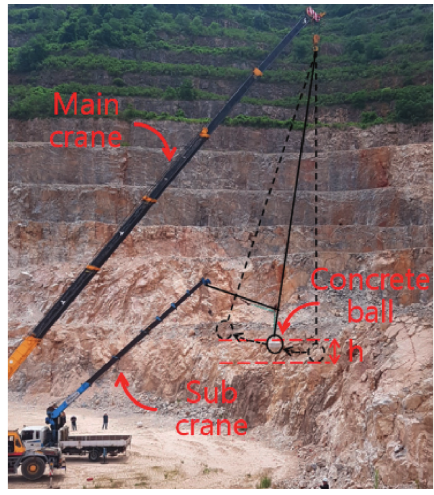
Figure 1: Overview of the pendulum test. Table 1: Details of the concrete ball used in the pendulum